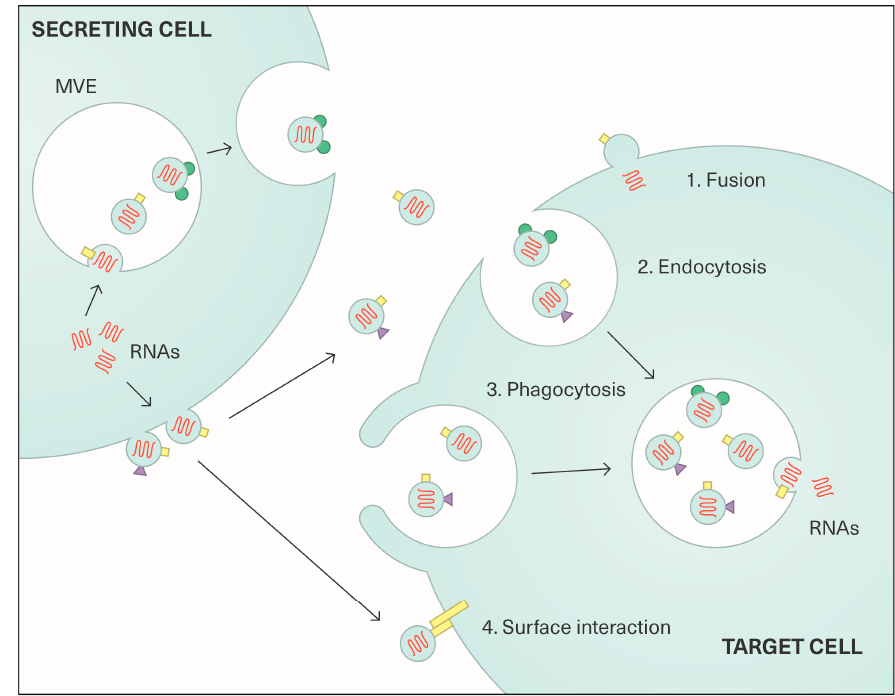
Figure 2. The four different modes of communication by exosomes and microvesicles. Extracellular vesicles serve as vehicles for cell-to-cell communication through horizontal transfer of bioactive molecules (proteins, lipids and nucleic acids). Extracellular vesicles (microvesicles (MVs) or exosomes (Exos)) produced from a secreting cell may be internalized by fusion (1), endocytosis (2), phagocytosis (3) or may interact with the membrane proteins of the target cell (4). Squares, triangles and circles represent membrane-associated proteins.